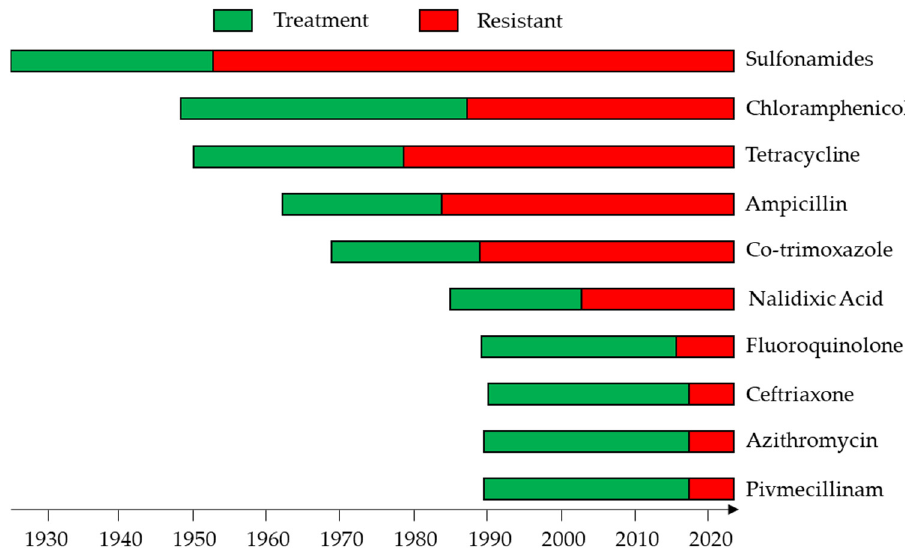
Figure 4. Global drug treatment against Shigella infection over the years and increase in antibiotic resistance developed to these drugs.